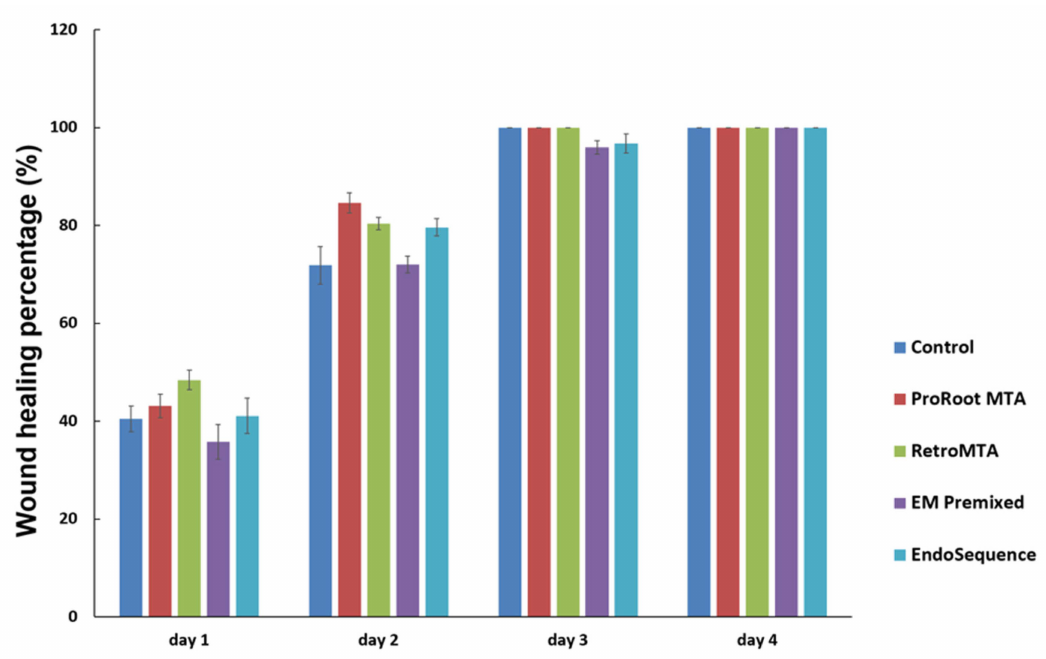
Figure 3. Comparison of cell migration by experimental cement. There were no significant differences between the experimental and control groups at each time point. Error bars mean standard deviations.